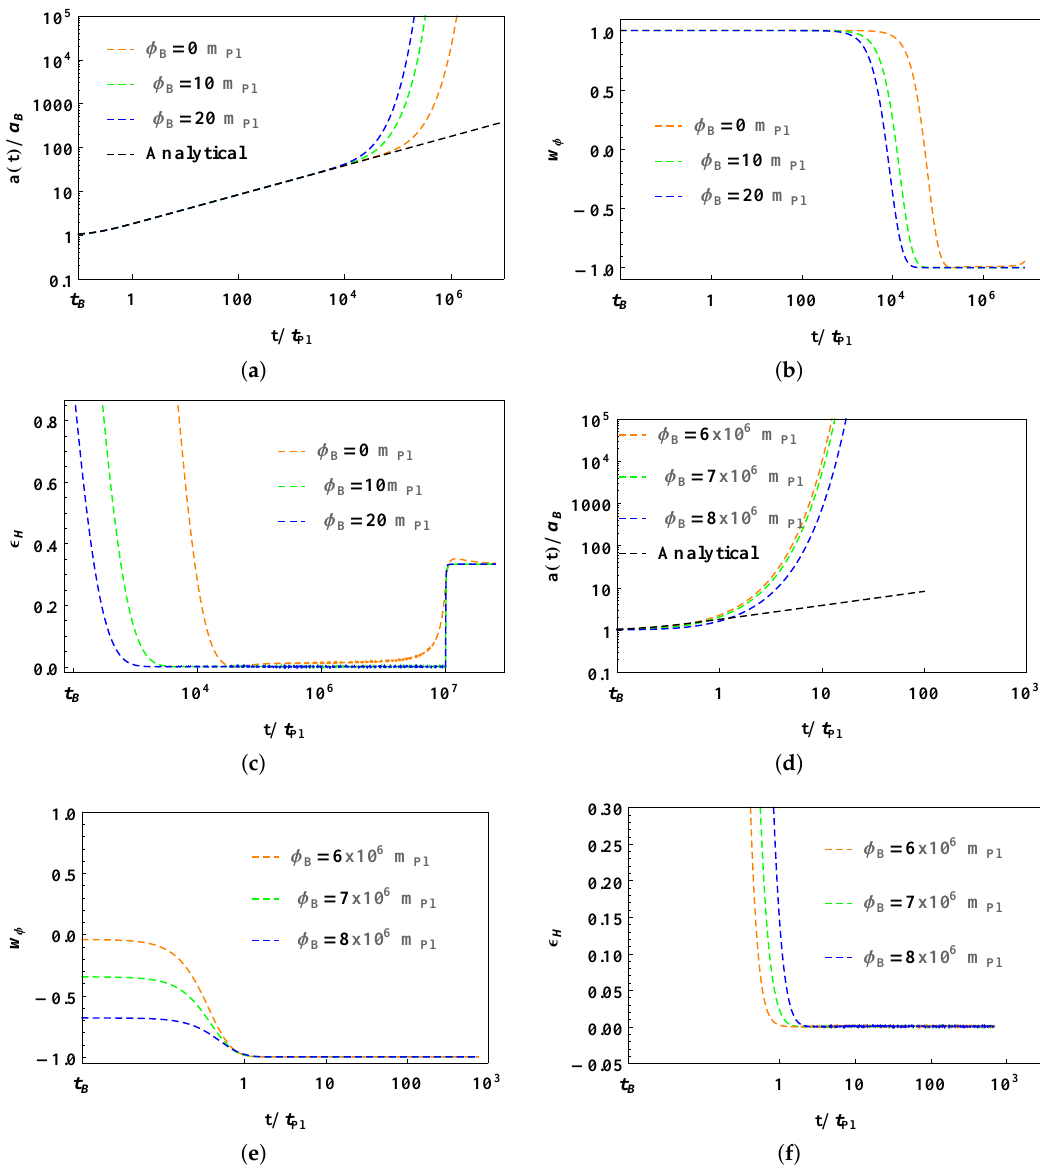
Figure 1. The numerical results for the potential (3) with n = 5/3 and ˙ φ B > 0. This figure exhibits the numerical evolution of a ( t ) , w ( φ ) , and (cid:101) H in case of the ( a – c ) kinetic energy-dominated (KED) and ( d – f ) potential energy-dominated (PED) initial values at the quantum bounce. The analytical solution of the scale factor (Equation (9)) is also displayed in order to compare it with the numerical solution shown in the ( a , d ). In the KED case ( a ), the evolution of a ( t ) shows universal feature while it disappears in the PED case ( d ). We chose m = 10 − 5 m pl and m pl = 1. One can also obtain a similar figure with ˙ φ B <